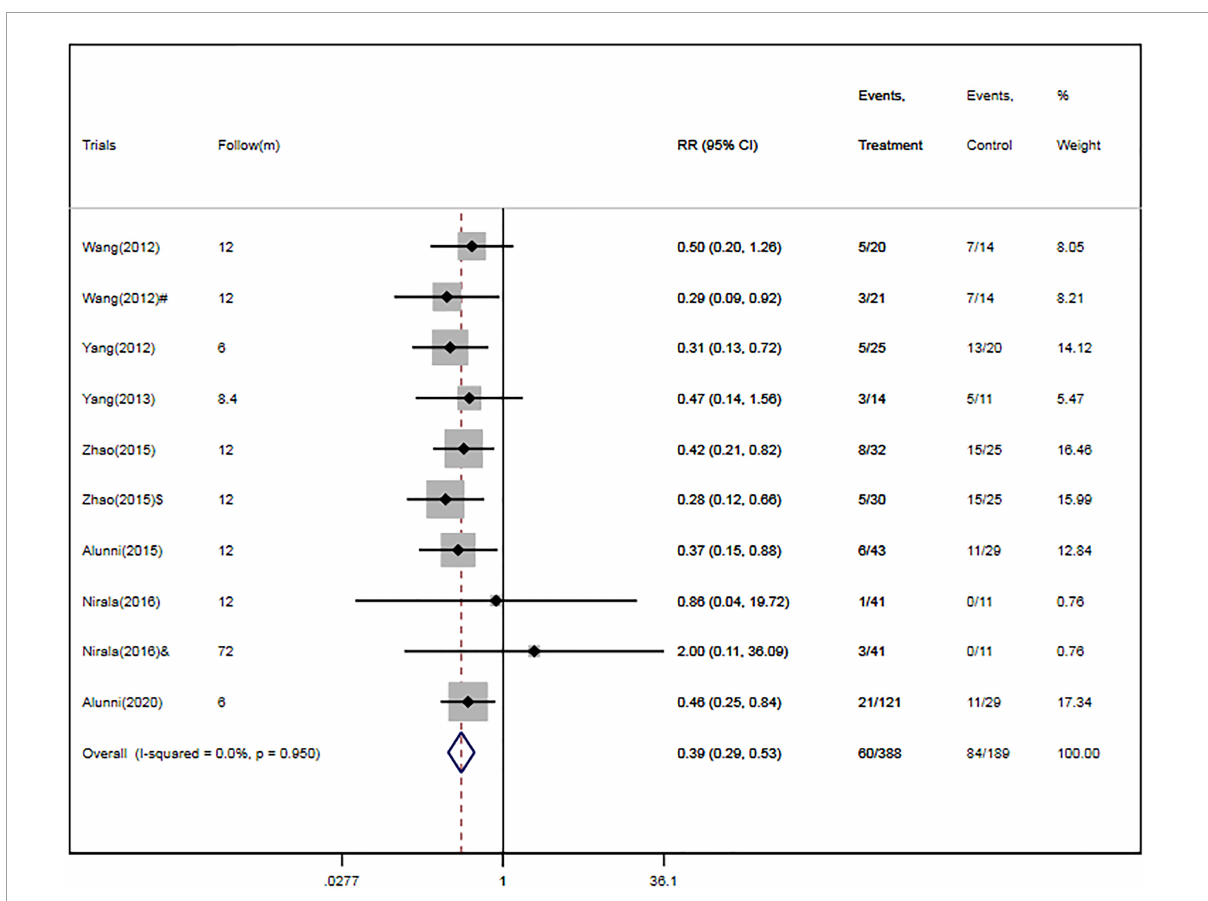
FIGURE3 CSWT plus OMT is associated with a decreased risk of MACEs. Fixed-effects model ( I 2 = 0.0%). CSWT, cardiac shock wave therapy; OMT, optimal medical therapy; MACE, major adverse cardiac event; RR, relative risk; CI, confidence interval. # Patients treated with short-term regimen of CSWT; $ , patients treated with an expanding scope CSWT; and & , patients with long-term